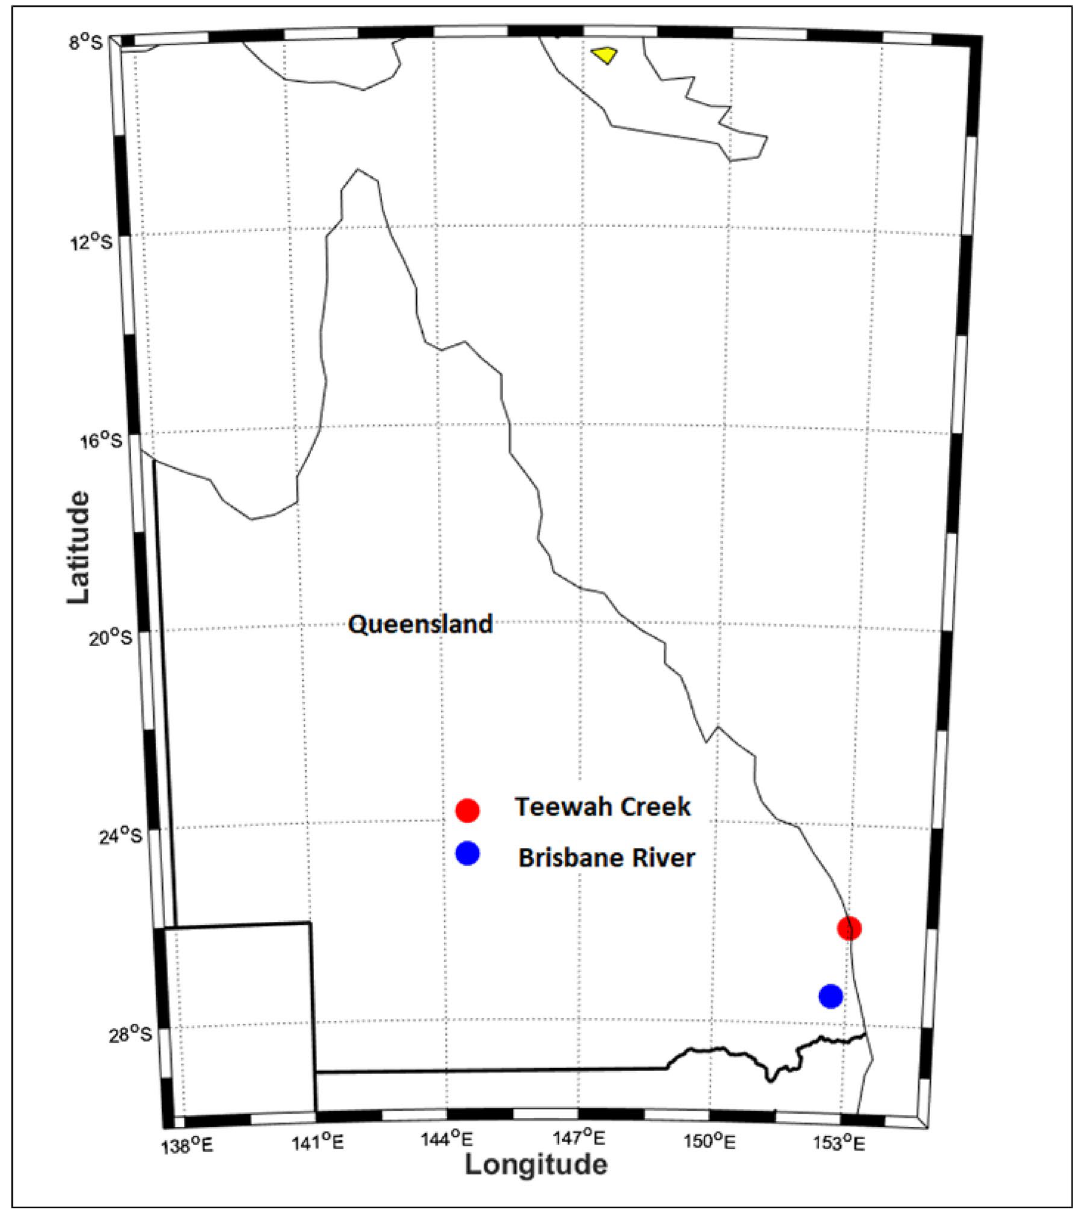
Figure 5. Location of Brisbane River and Teewah Creek study site in Australia, where experiments are carried out to validate the Deep Learning model for the prediction of hourly streamflow ( Q , m 3 s −1